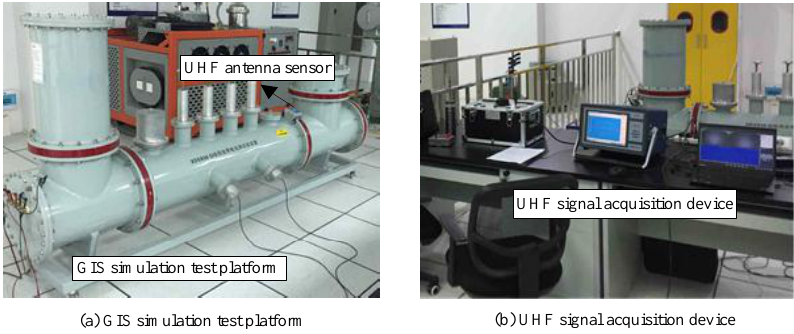
Figure 4. Simulation test platform. GIS gas insulated switchgear; UHF, ultra-high frequency.